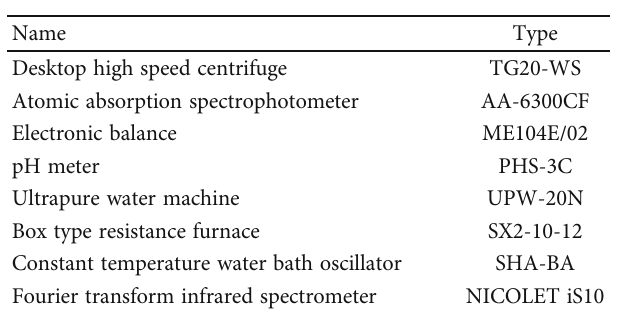
Table 1: Experimental equipment.